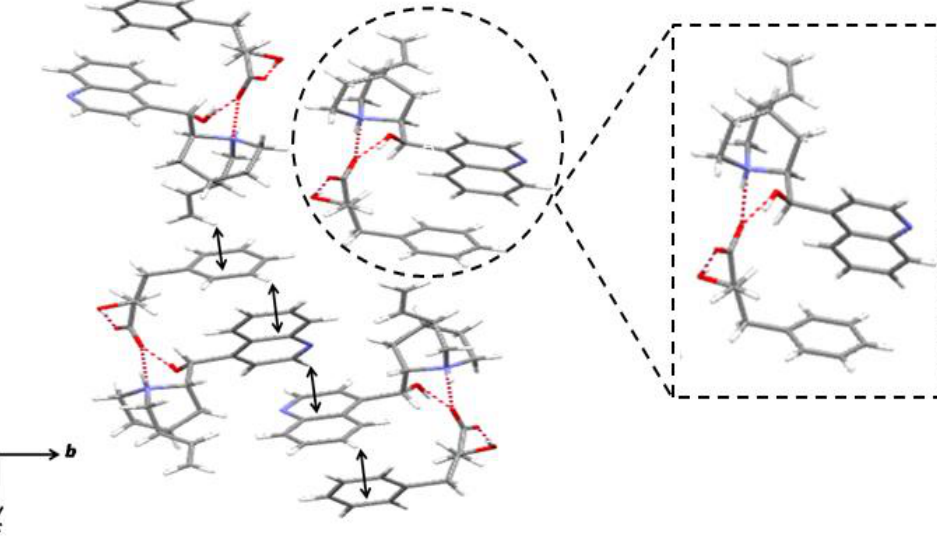
Figure 3. The ( R )- 1 · cinchonidine salt obtained in an EtOH solution, viewed from the a -axis. The dotted lines and arrows indicate hydrogen bonds and CH/ π interactions, respectively.